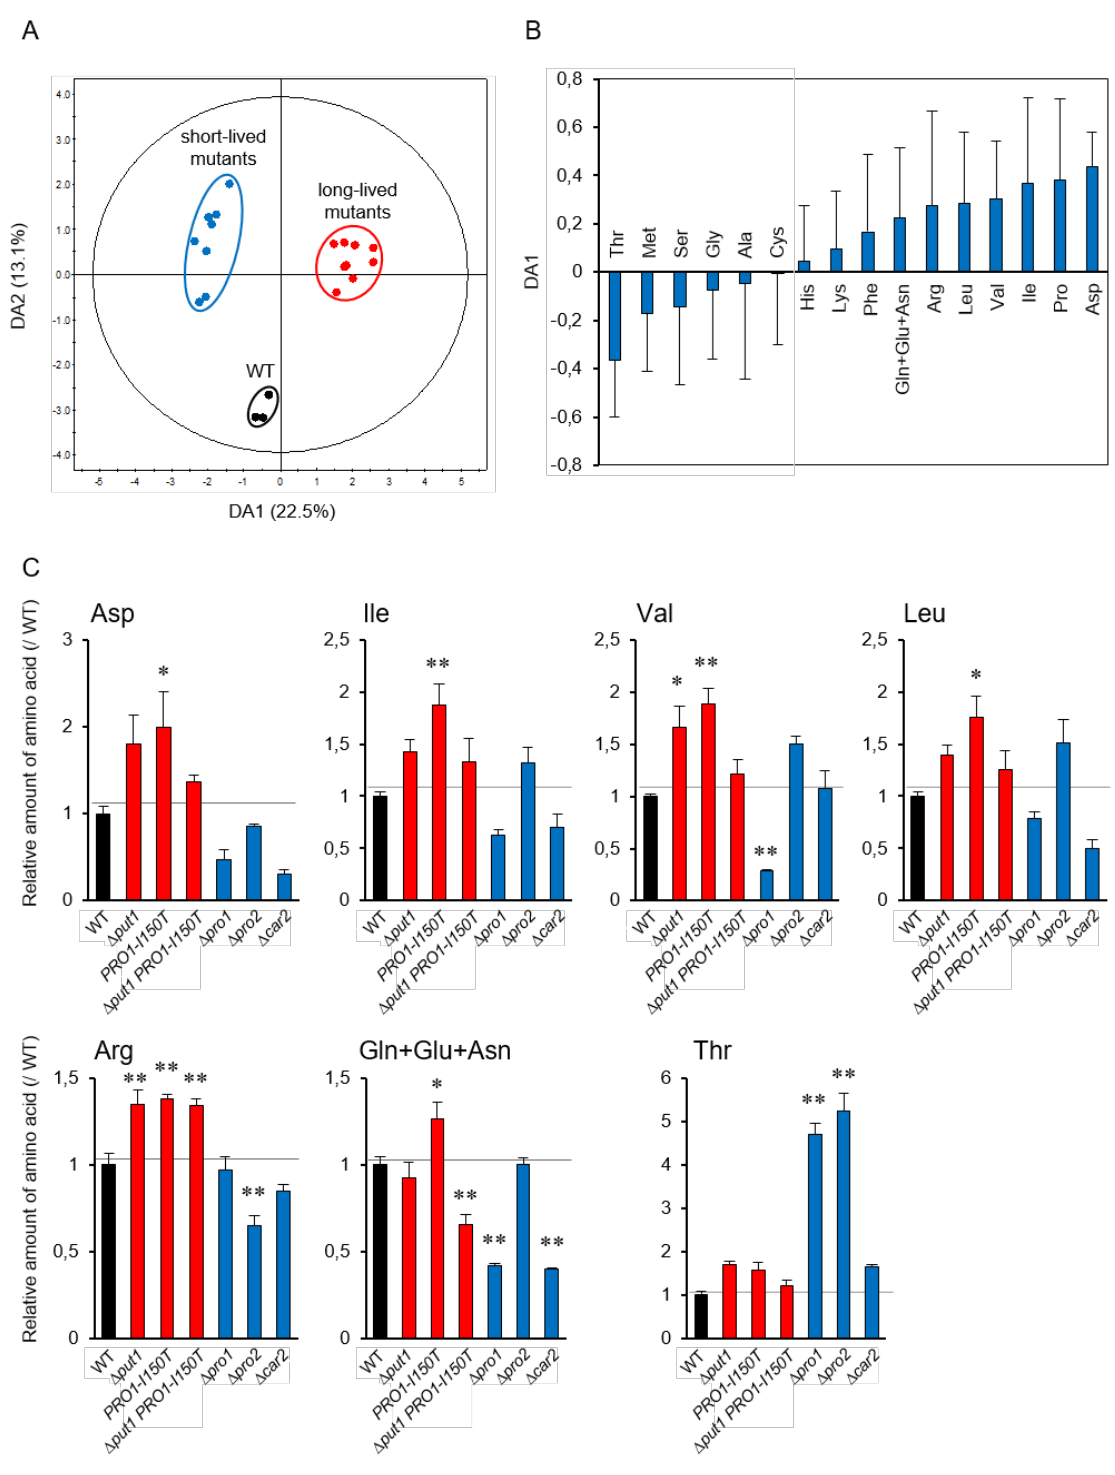
FIGURE 3: OPLS-DA of amino acid analysis data from yeast mutants involved in proline metabolism. (A) Score plot of OPLS-DA for the wild- type strain (WT; BY4741) and short- and long-lived mutants involved in proline metabolism. (B) Loading plot for DA1 in panel (A). (C) Each point represents an individual batch from WT and the mutants for indicated gene at log phase. The values are the means and standard devi- ation of results from three independent experiments. *, p < 0.05; **, p < 0.01, versus WT calculated with the Dunnett’s